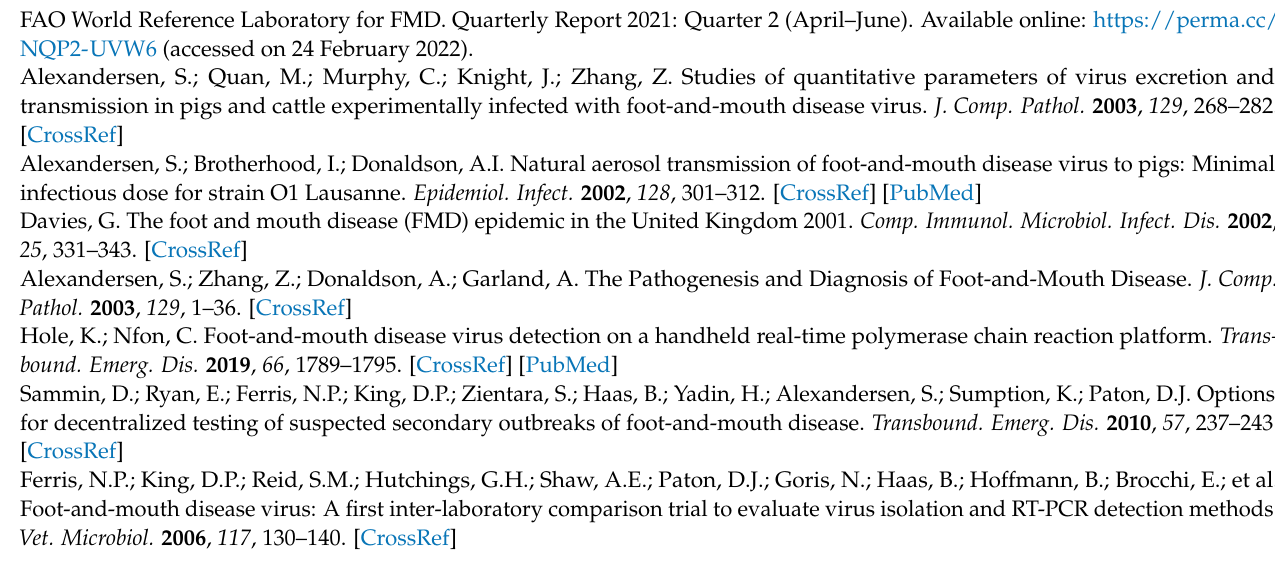
Table S2: Serology data returned by the participants. Table S3: Field samples with false positive results in the NSP